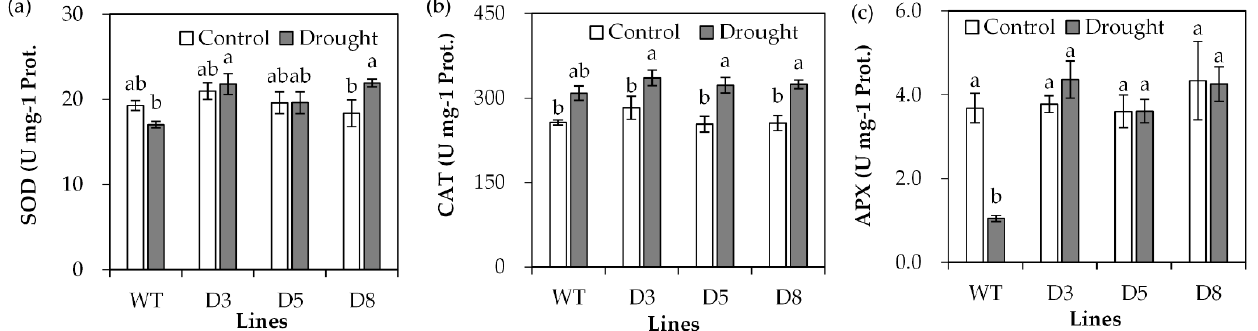
Figure 7. Analysis of antioxidant enzyme activities in transgenic plants in comparison with the wild type (WT). Three-week old seedlings were withheld from irrigation for 14 days (drought) or continuously irrigated as control, and leaves were sampled for measurements of SOD ( a ), CAT ( b ) and APX ( c ) activities. Means of three replicates and standard errors are presented; the same letter above the column indicates no significant difference at p < 0.05.